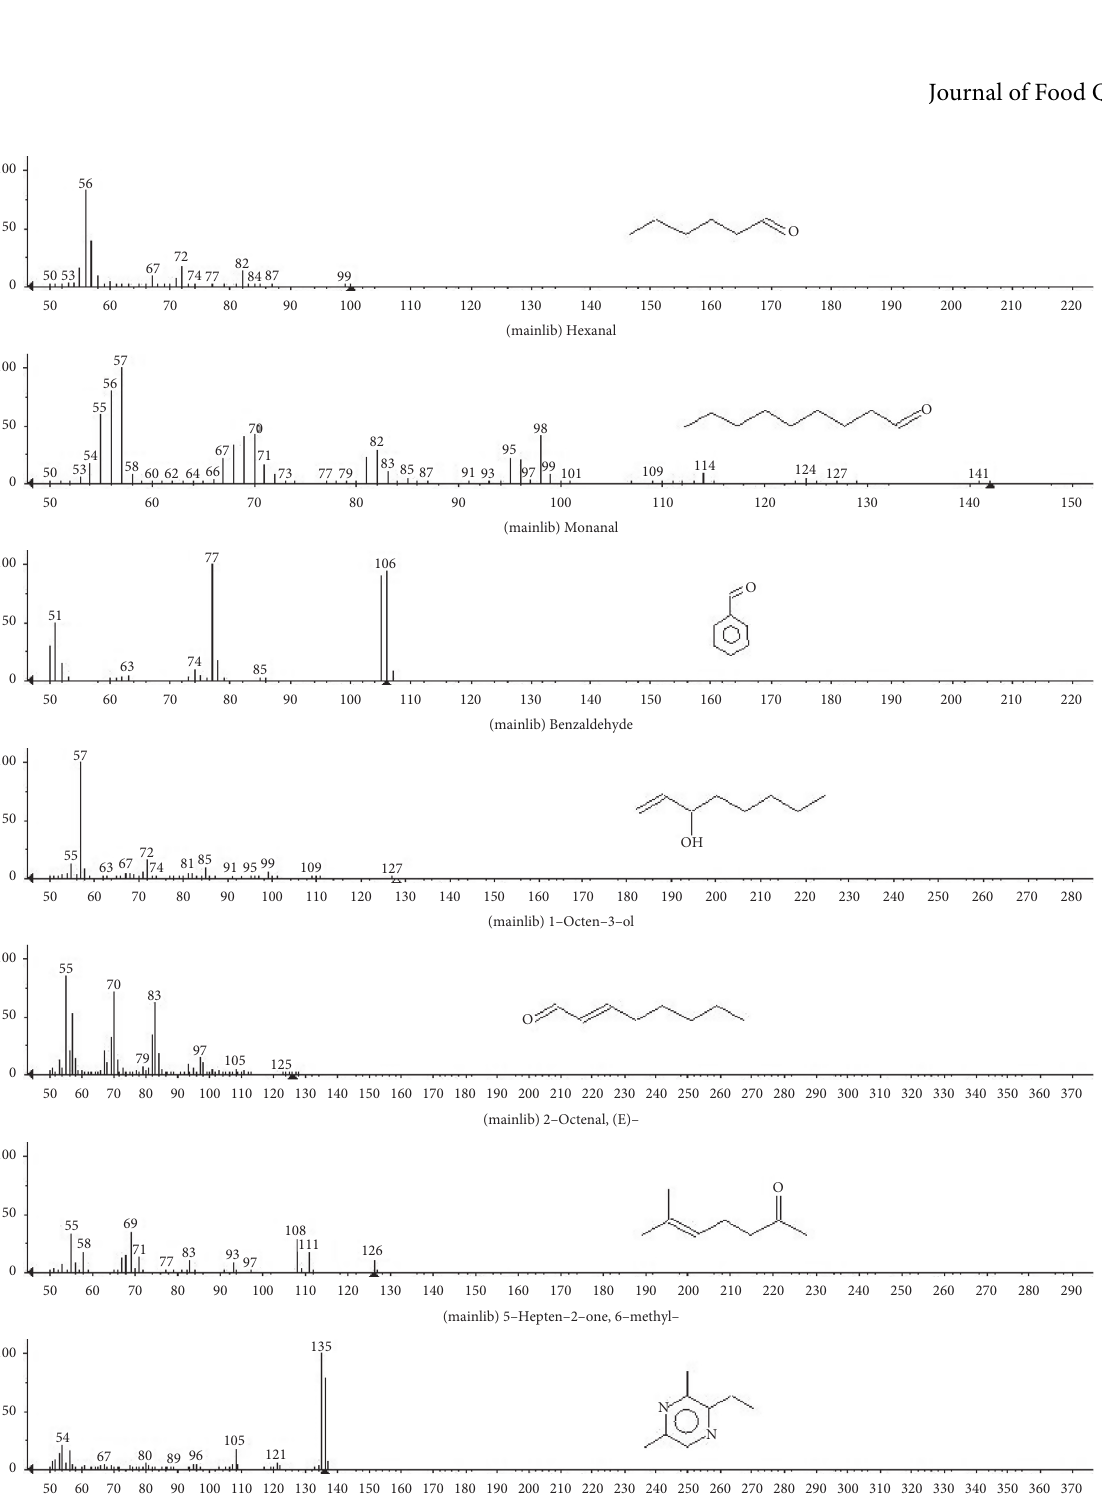
Figure 5: The mass spectra of the key